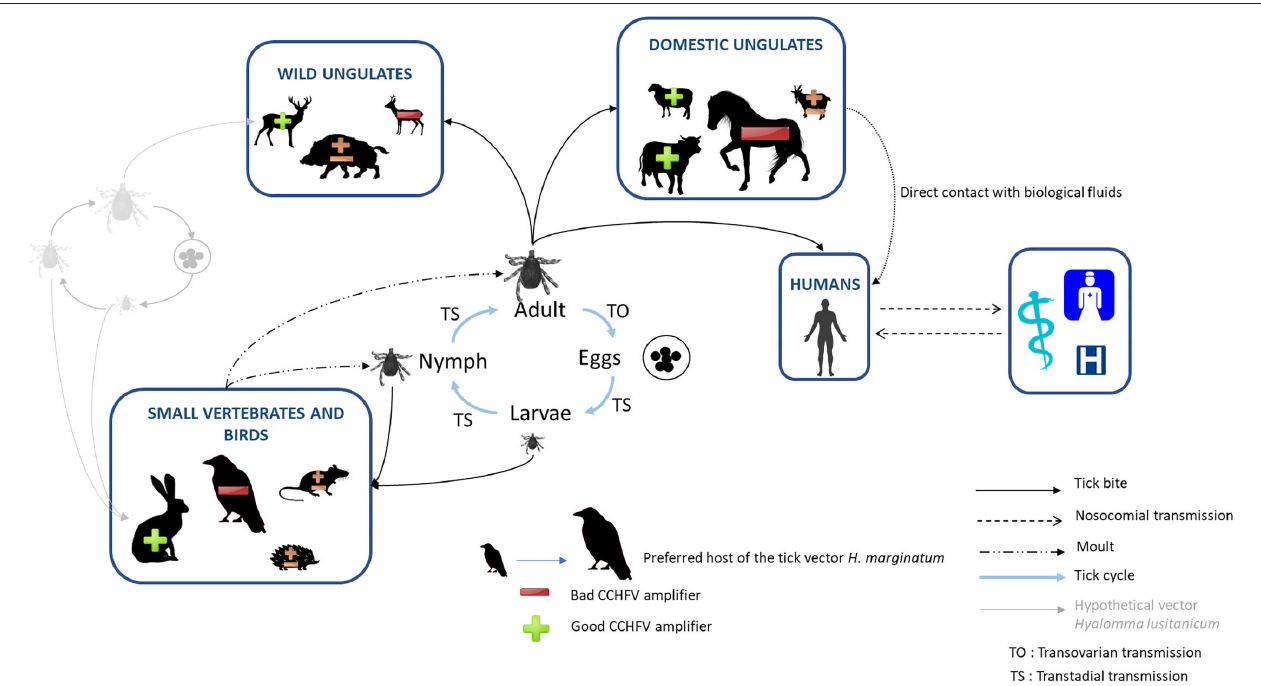
FIGURE 2 | Presumed enzootic transmission cycle of CCHFV in France, involving the candidate tick vector H. marginatum and its different vertebrate hosts. Animals are represented in different sizes according to relative host preferences of H. marginatum . The ability of these animals to replicate CCHFV is indicated by “ + ” for good CCHFV amplifiers and “–” for bad CCHFV